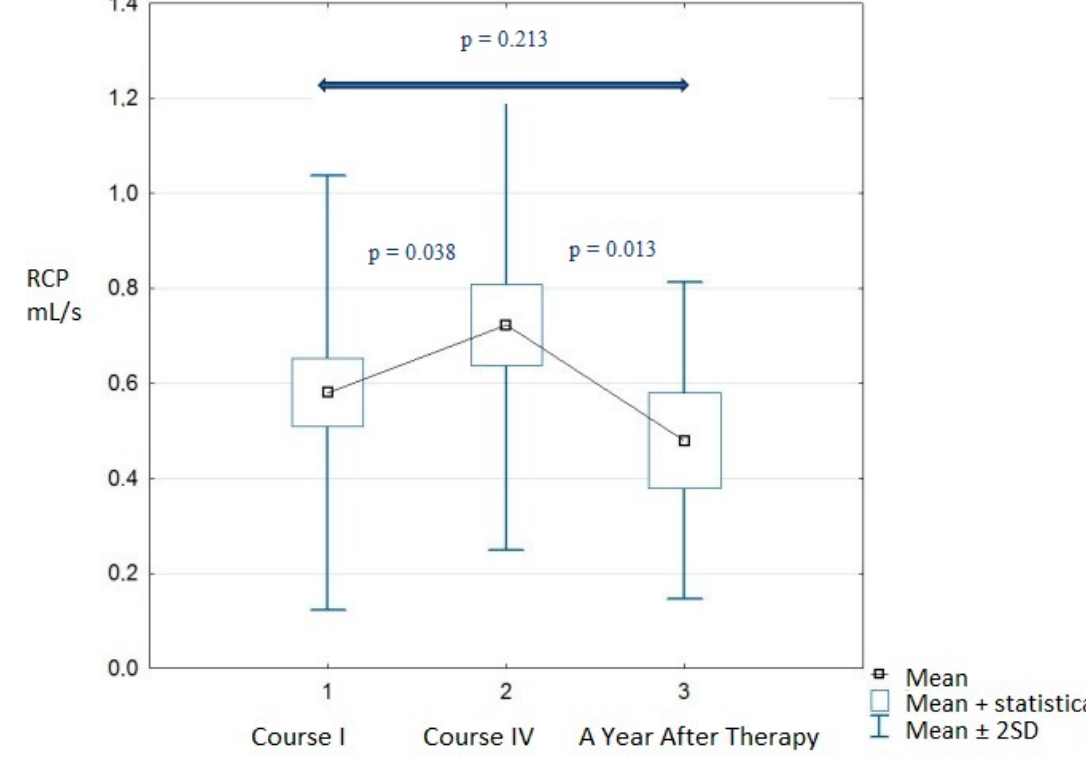
Figure 1. Renal cortex perfusion during observations.